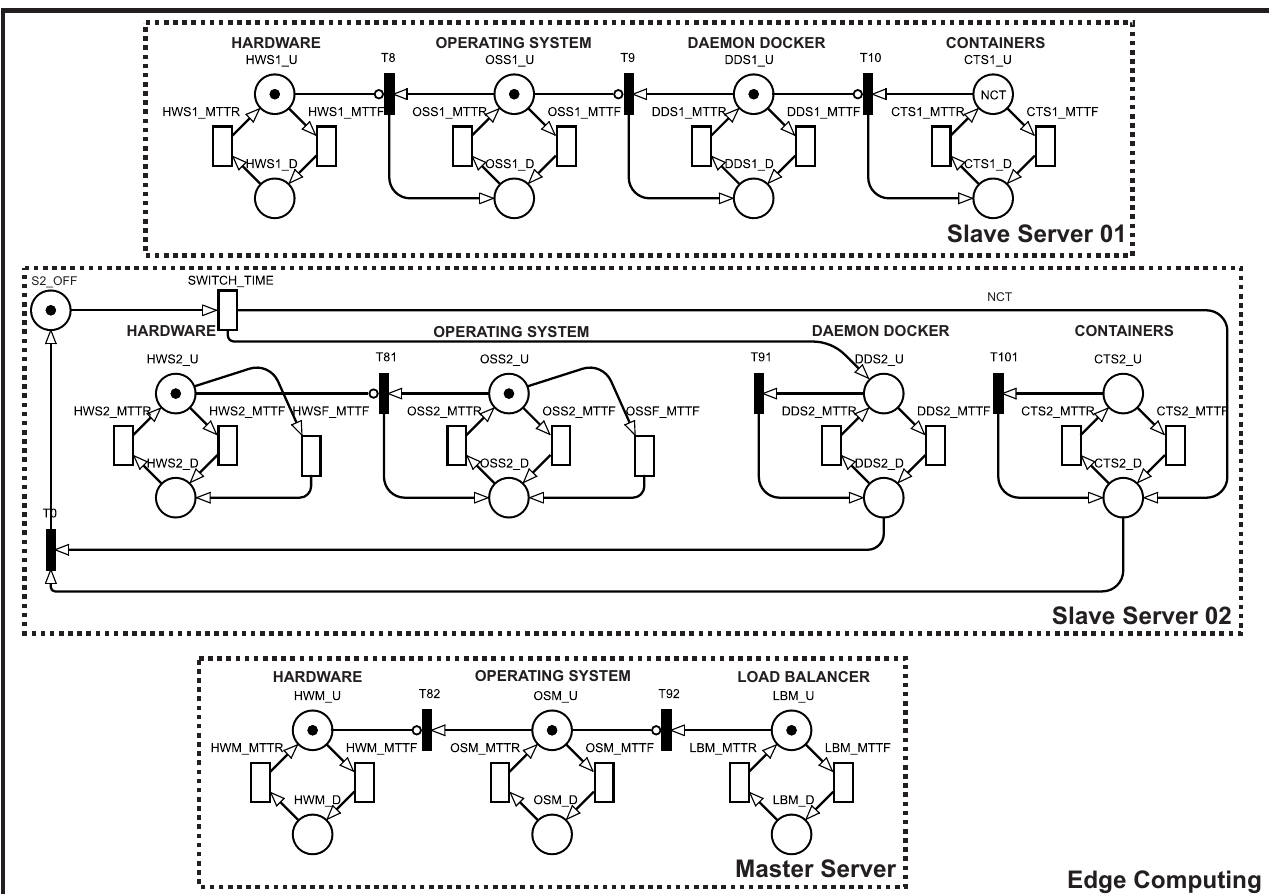
Figure 15. Extended SPN model for an MEC architecture with redundant slave server.